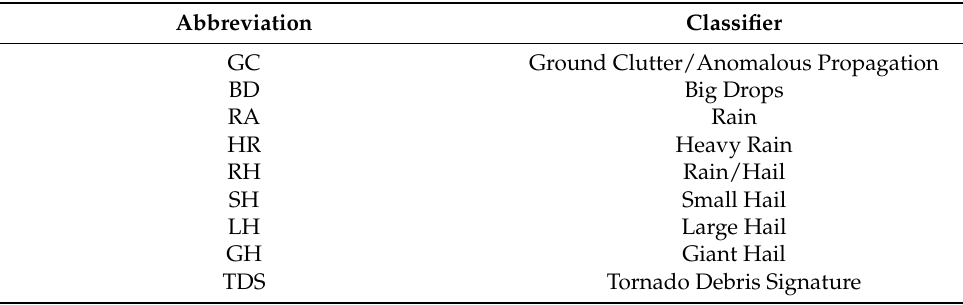
Table 3. List of HCA abbreviations and respective